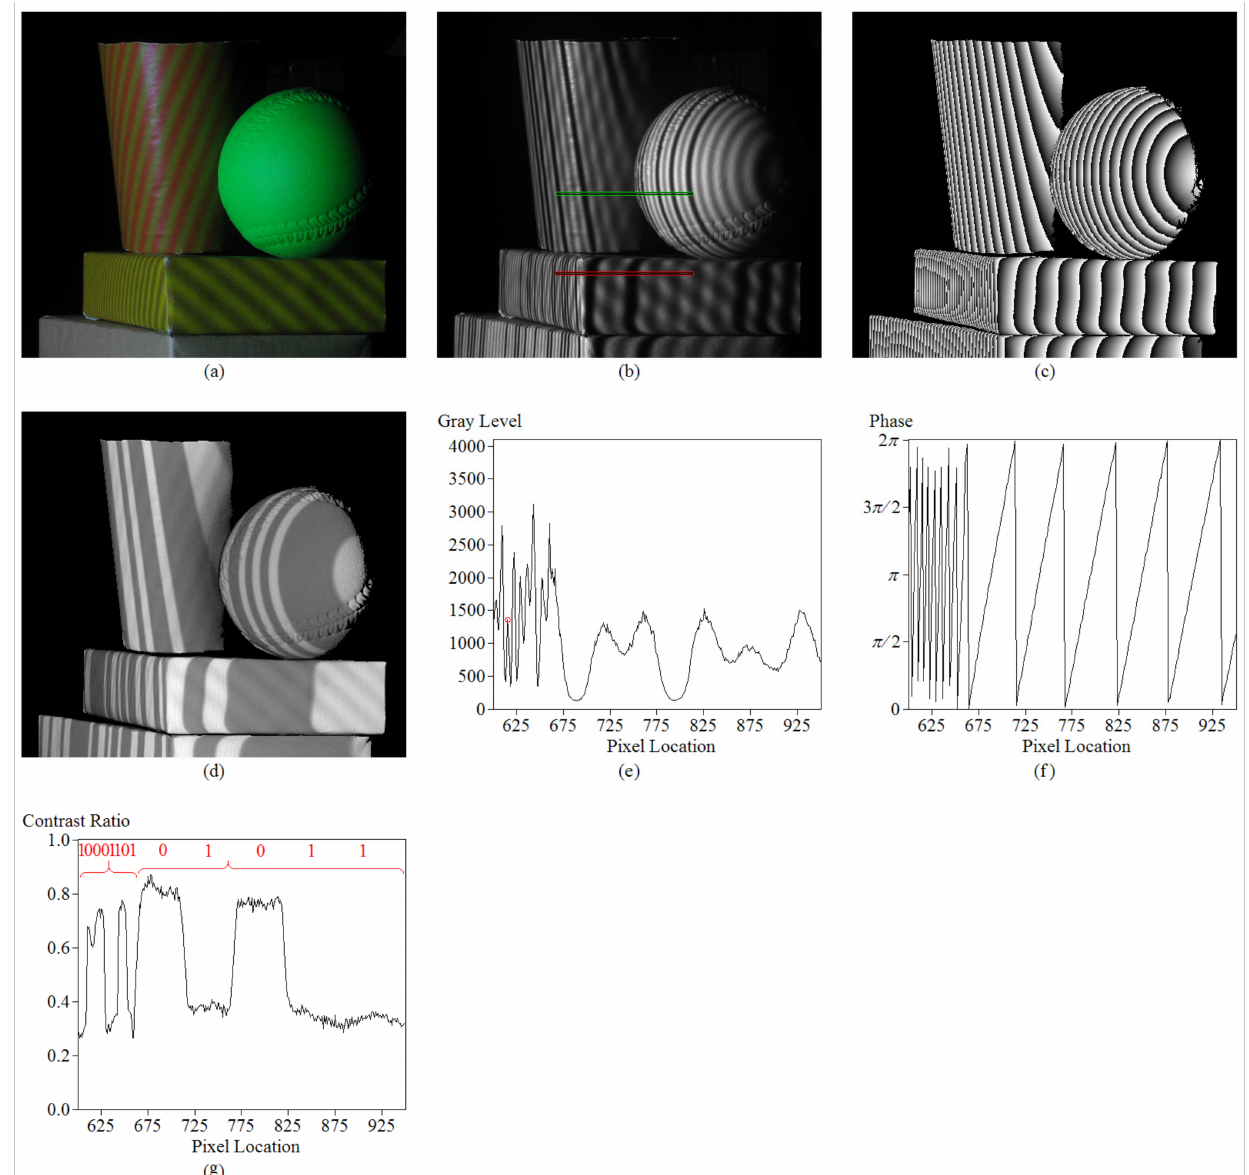
Figure 16. ( a ) An appearance of the inspected objects. ( b ) An image that was obtained from the first pattern projection on the objects. ( c ) The extracted phase map. ( d ) The contrast map. ( e ) The gray-level distribution along the image row that is marked with a red frame in ( b ). ( f ) The corresponding 1D phase distribution. ( g ) The corresponding 1D contrast